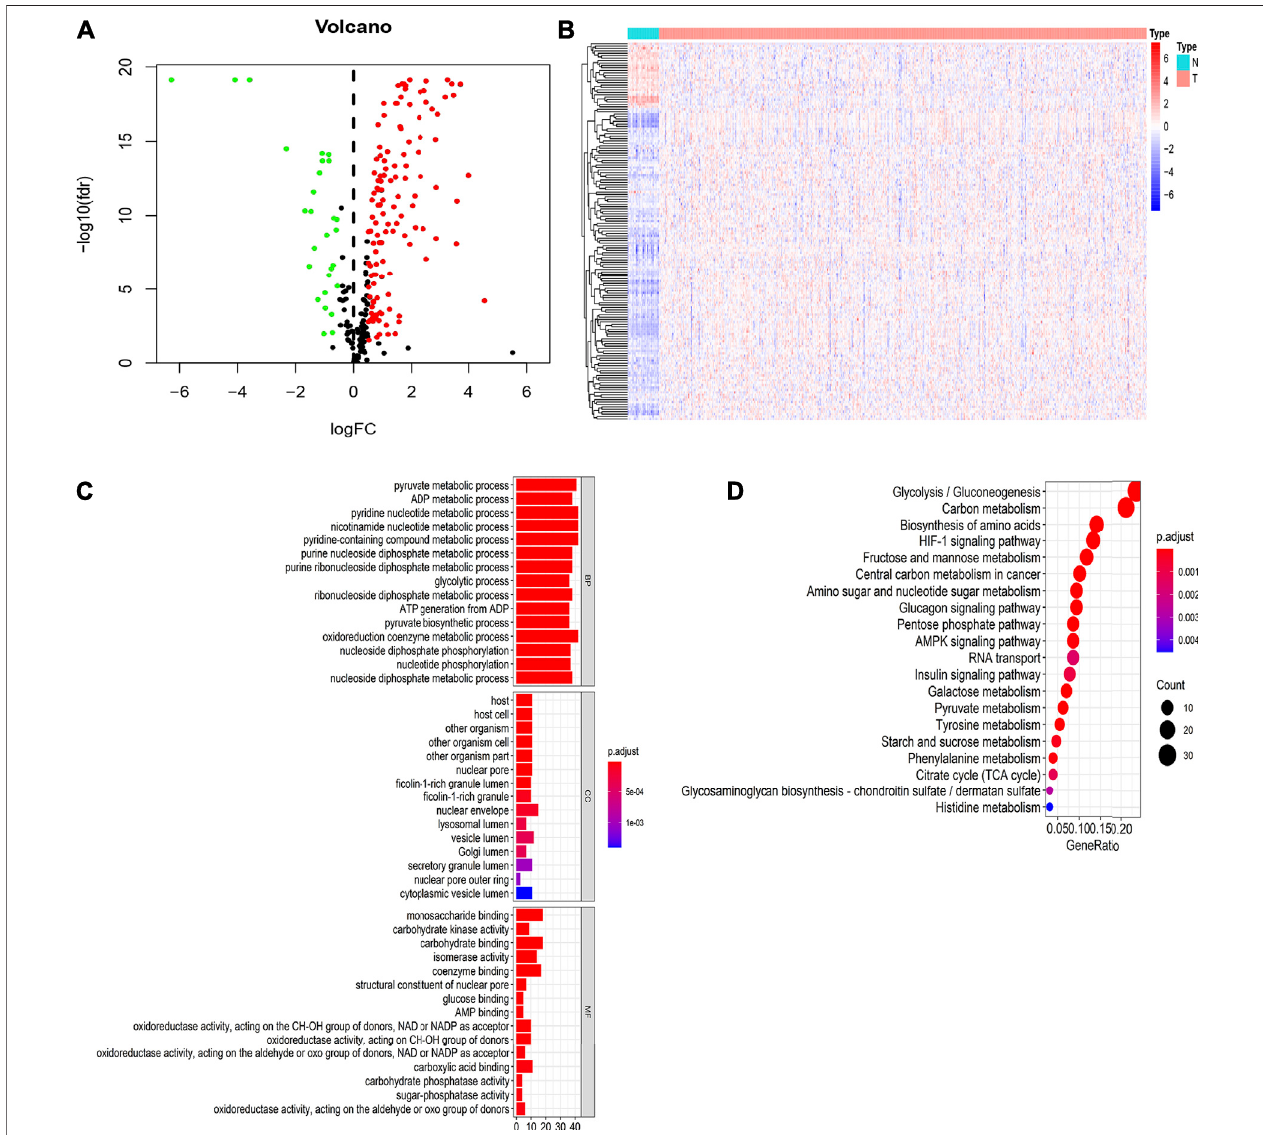
FIGURE 3 | Identi fi cation of differentially expressed genes (DEGs) related to glycolysis of TCGA datasets between normal and EC tissues and GO and KEGG pathway enrichment analysisofDEGs (A) .Differentialexpression genesbetweentwogroups. Thered dotistheup-regulated gene,thegreendotisthedown-regulated gene, and the black dot is the other genes without signi fi cant difference screened by the criteria of |Fold Change| > 0.5 and FDR < 0.05 (B) . Hierarchical clustering of differentially expressed genes in two groups (C) . The GO functional enrichment analysis of differential genes includes three domains: molecular function, biological process, and cell composition (D) . KEGG pathway analysis of differentially expressed